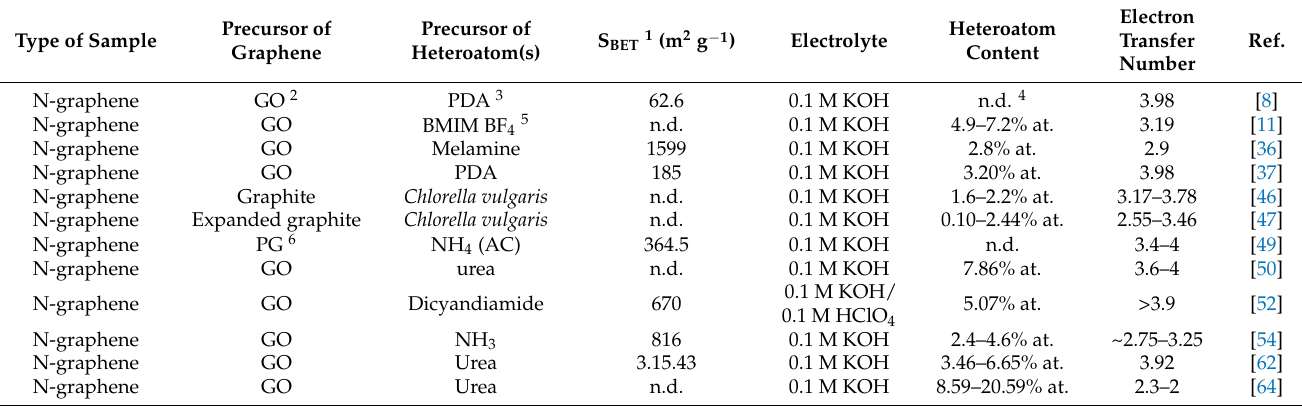
Table 1. Summary of nitrogen-doped graphene obtained via the pyrolysis method as an electrocatalyst for ORR.